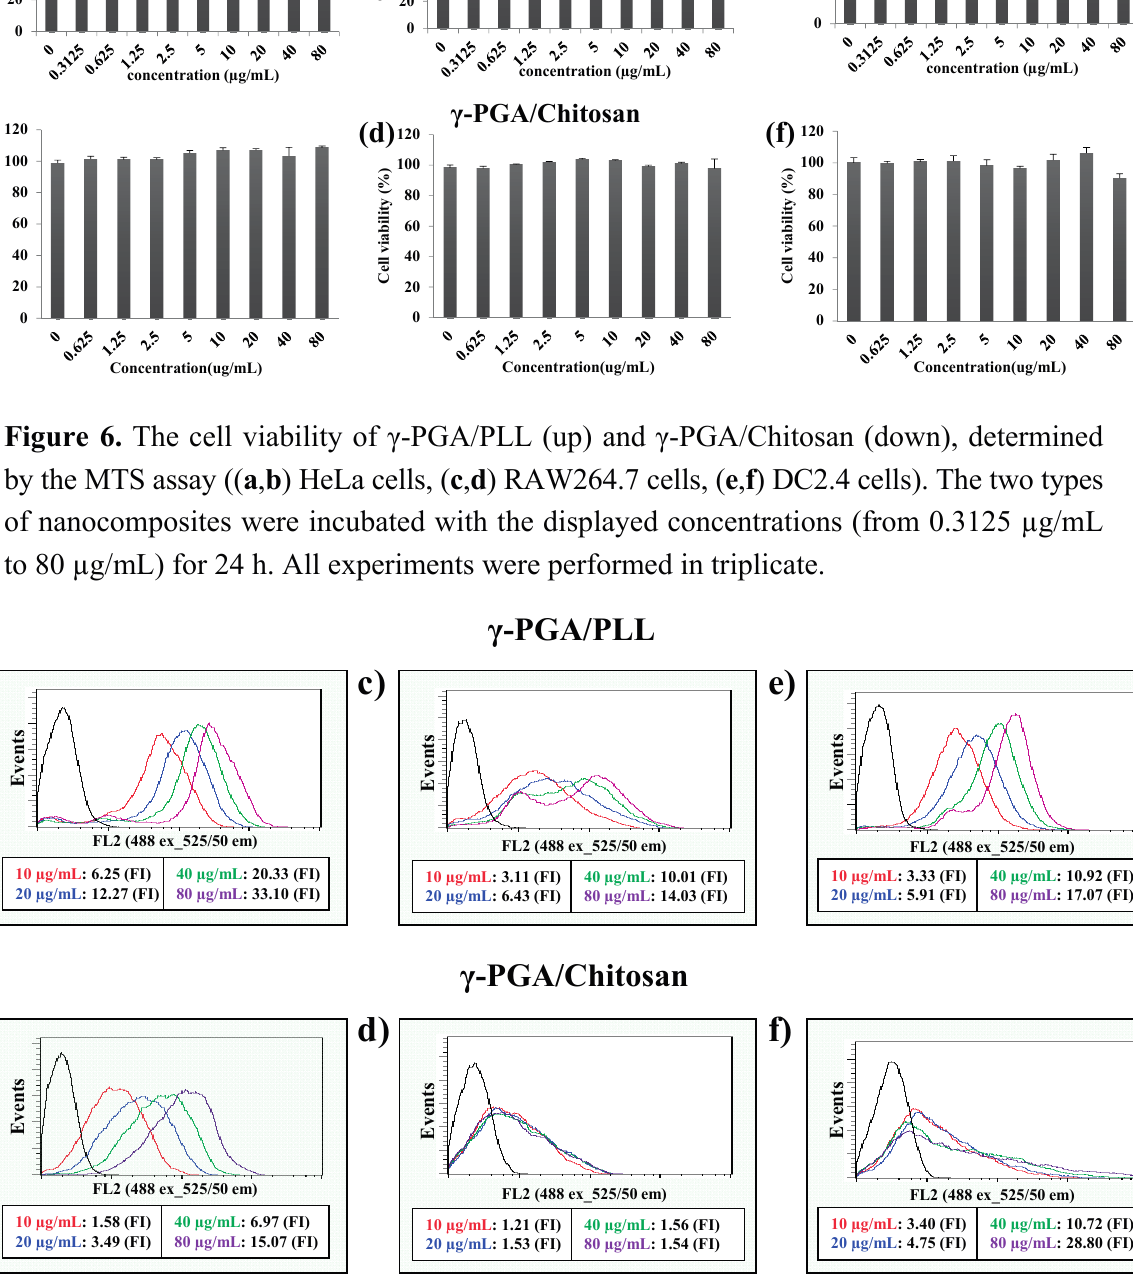
Figure 7. The flow cytometry analysis of γ -PGA/PLL (up) and γ -PGA/Chitosan (down), respectively (( a , b ) HeLa cells, ( c , d ) RAW264.7 cells, ( e , f ) DC2.4 cells). The two types of nanocomposites were incubated with various concentrations (from 10 µg/mL to 80 µg/mL) for 24